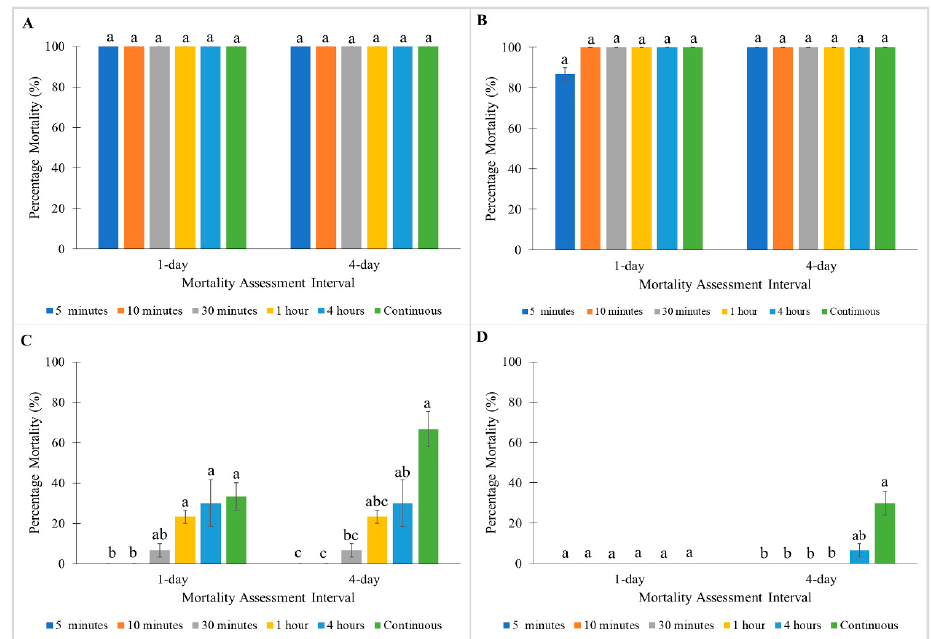
Figure 3. Influence of exposure time on Pesguard FG161 on percentage mortalities of a susceptible C. lectularius strain and three C. hemipterus strains at 1 and 4 days post-treatment. ( A ) Monheim, ( B ) Madam Mo, ( C ) Tanjong Tokong, ( D ) Green Lane strains. Bars with different letters are significantly different (Kruskal–Wallis test, p < 0.05).